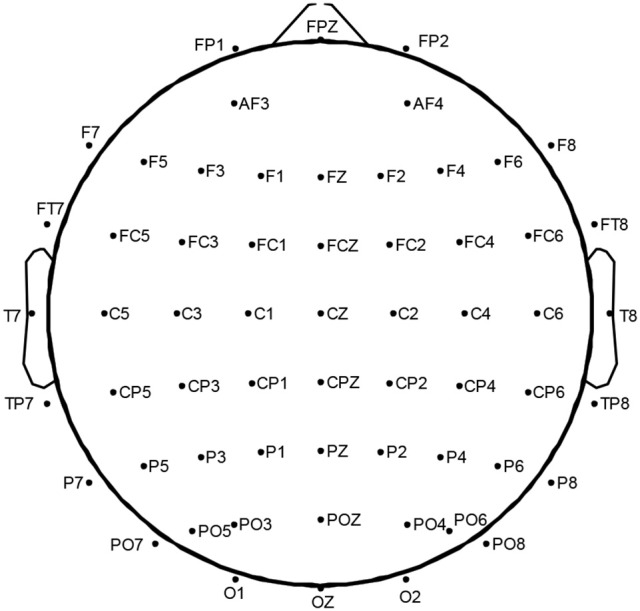
International 10–20 system for 60 electrodes.